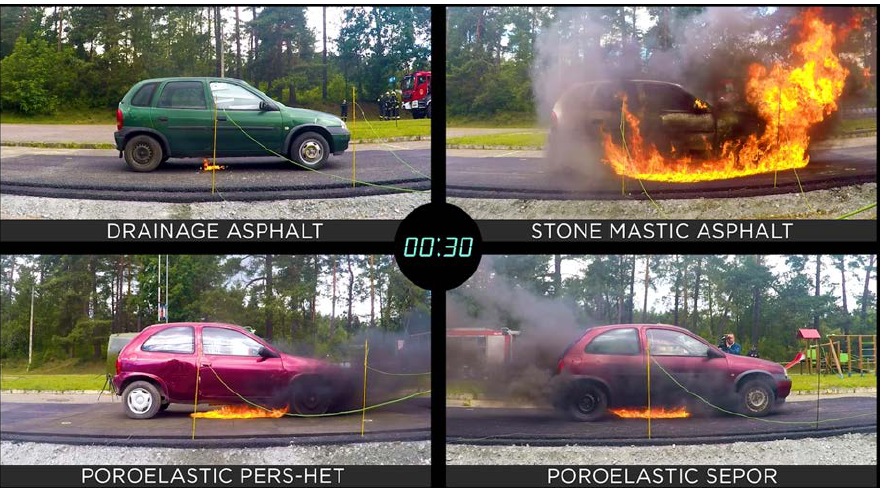
Figure 40. Development of fire 30 s after ignition.